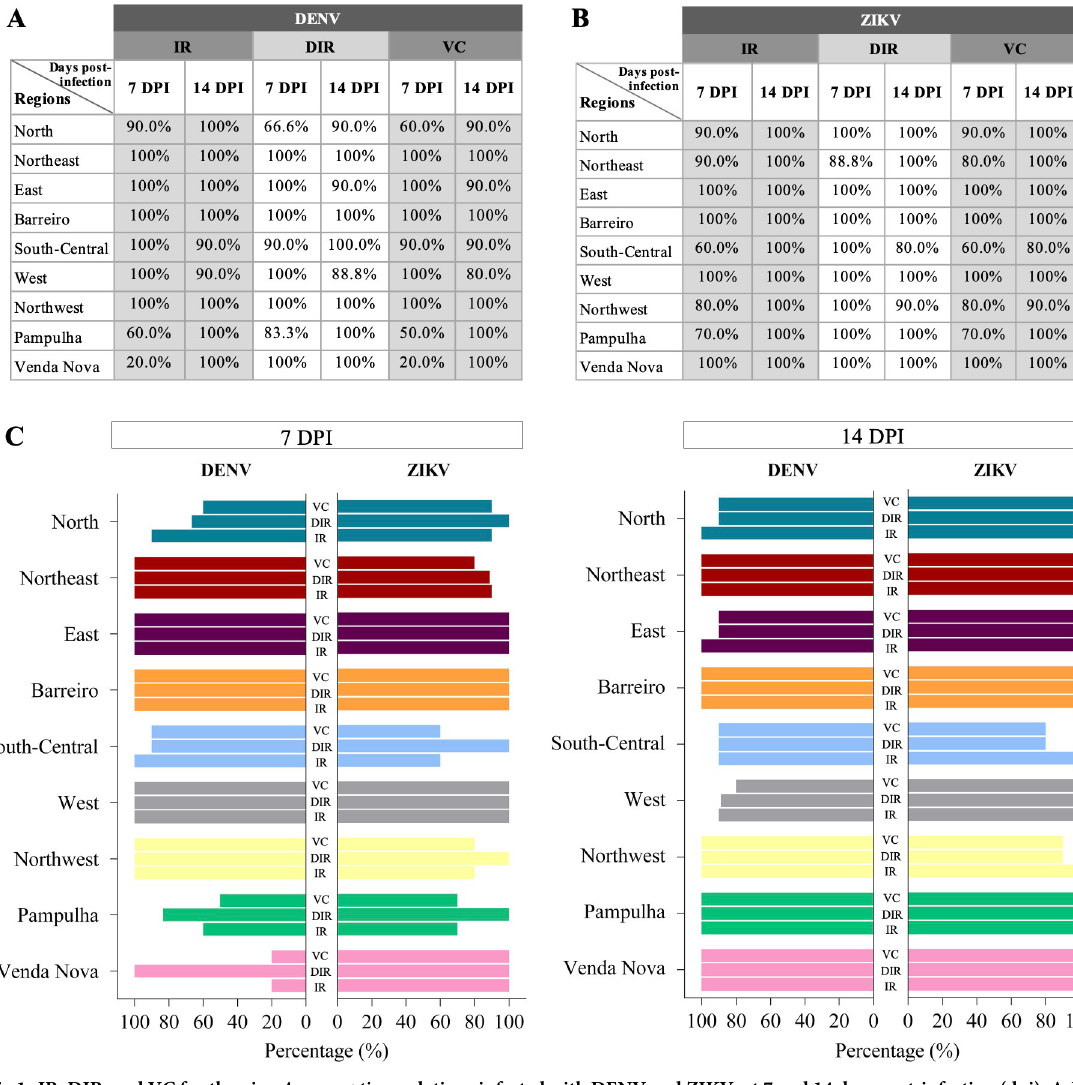
Fig 1. IR, DIR, and VC for the nine Ae . aegypti populations infected with DENV and ZIKV, at 7 and 14 days post-infection (dpi). A-B : Values of IR, DIR, and VC for the Ae . aegypti populations infected with DENV ( A ) and ZIKV ( B ). C : Comparison of the pattern of IR, DIR, and VC sets for each population, previously described in A-B, between DENV and ZIKV at 7 and 14 dpi. The bars represent the rates and were disposed of in a model that highlights each population’s specific patterns. No association is detected between DENV and ZIKV infection patterns of the populations, neither in 7 nor in 14 dpi. IR: Infection rate, the proportion of infected mosquitoes of the total number of mosquitos tested. DIR: Disseminated infection rate, the proportion of infected head/salivary gland (SG) of the total number of infected mosquitos. VC: vector competence, the proportion of infected head/SG of the total number of tested